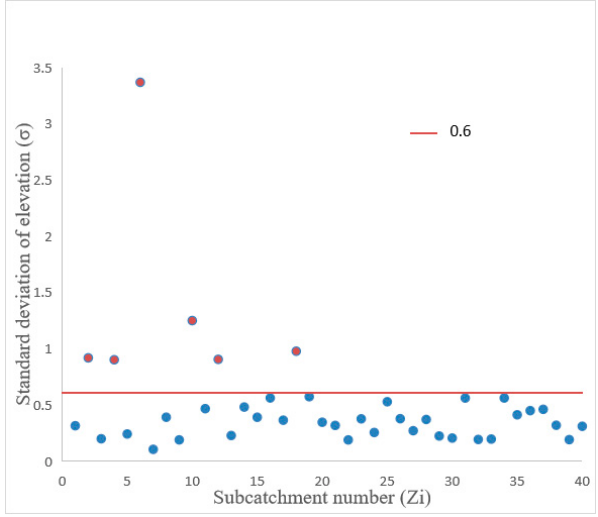
Figure 9. Subcatchments that need to be further divided (red dots) and subcatchments areas that needn’t further division (blue dots).